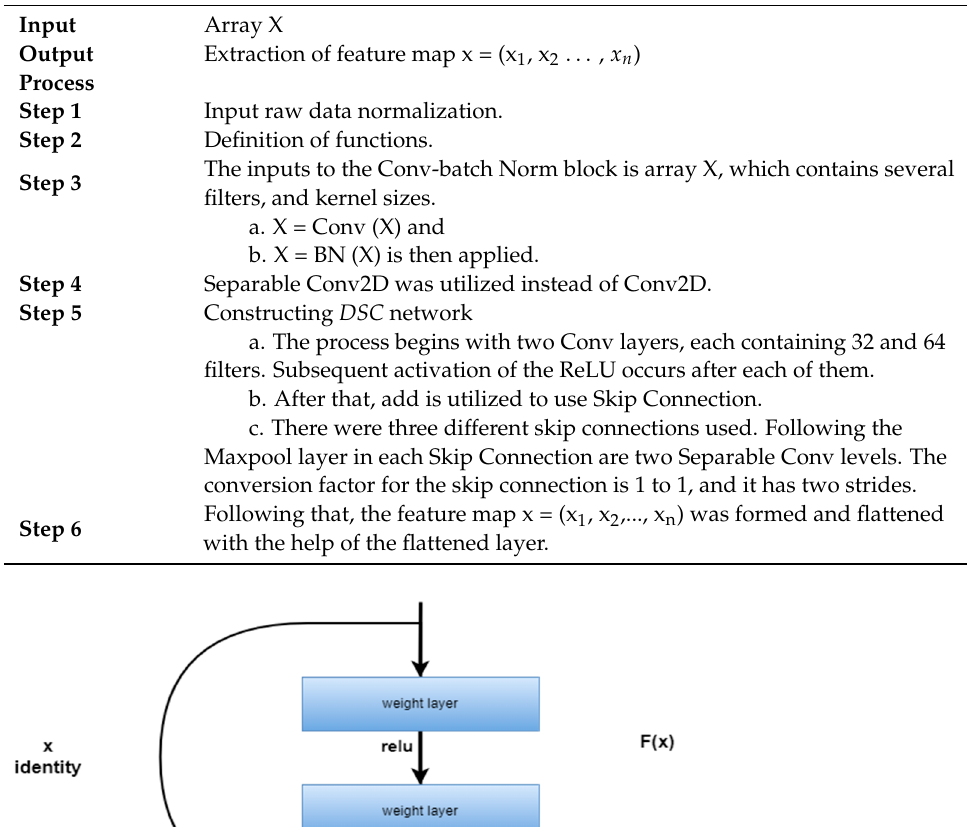
Algorithm 1: Implementation of the DSC model for feature map extraction